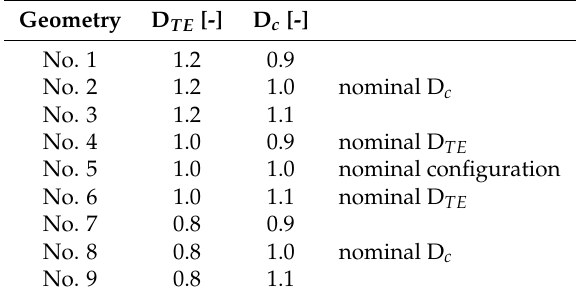
Table 1. Test matrix (with trailing-edge and coolant non-dimensional diameters. Geometry D TE [-] D c